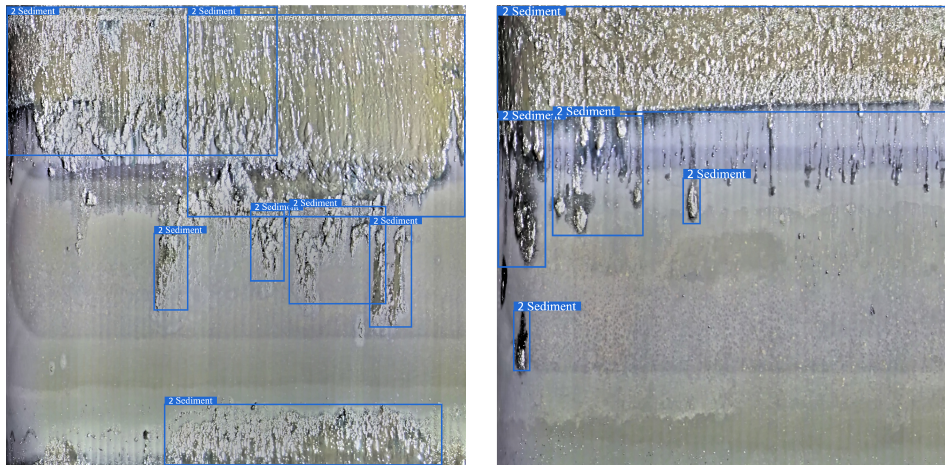
Figure 20. Detection result on the drainage